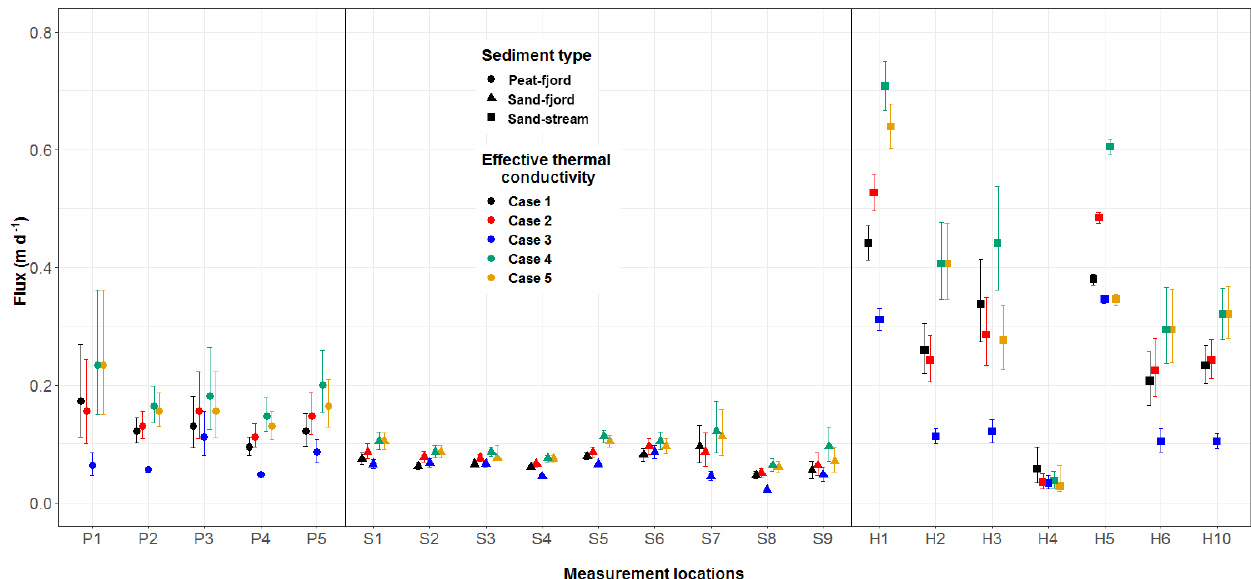
Figure 4. Vertical groundwater fluxes estimated at the test sites by assuming various distributions of sediment thermal conductivity (Cases 1–5). Sites with identification of P refer to the peat-covered area in the lagoon, S to the sand-covered area in the lagoon and H to the stream site (Fig. 1b,